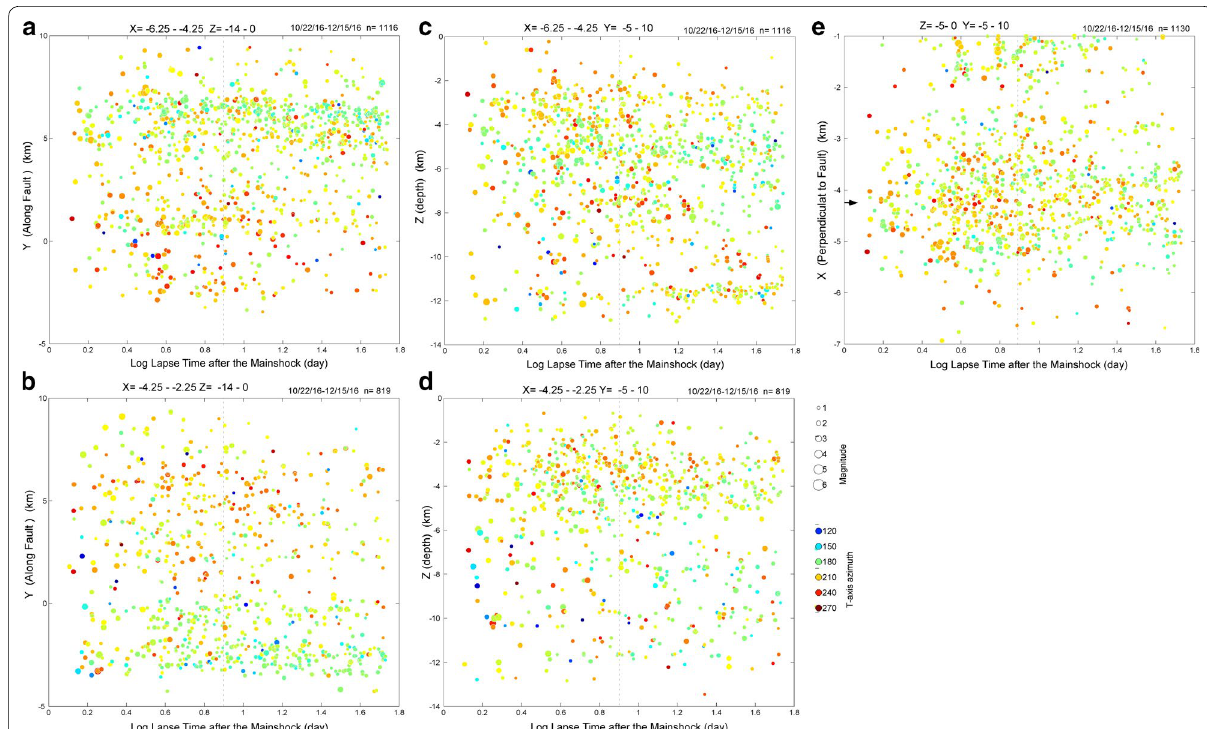
Fig. 5 Temporal changes in T-axis azimuths with the horizontal (time) axis of the logarithm of the number of days elapsed after the mainshock. Temporal changes in T-axis azimuths for aftershocks in the western and eastern sides of the fault are displayed with the distance Y in the direction along the fault on the vertical axis in a and b , and with the depth Z on the vertical axis in c and d . The temporal change in the shallow region including the subregion shown in Fig. 4c is displayed in e with the distance X in the direction perpendicular to the fault on the vertical axis. The arrow approximately indicates the location of the estimated